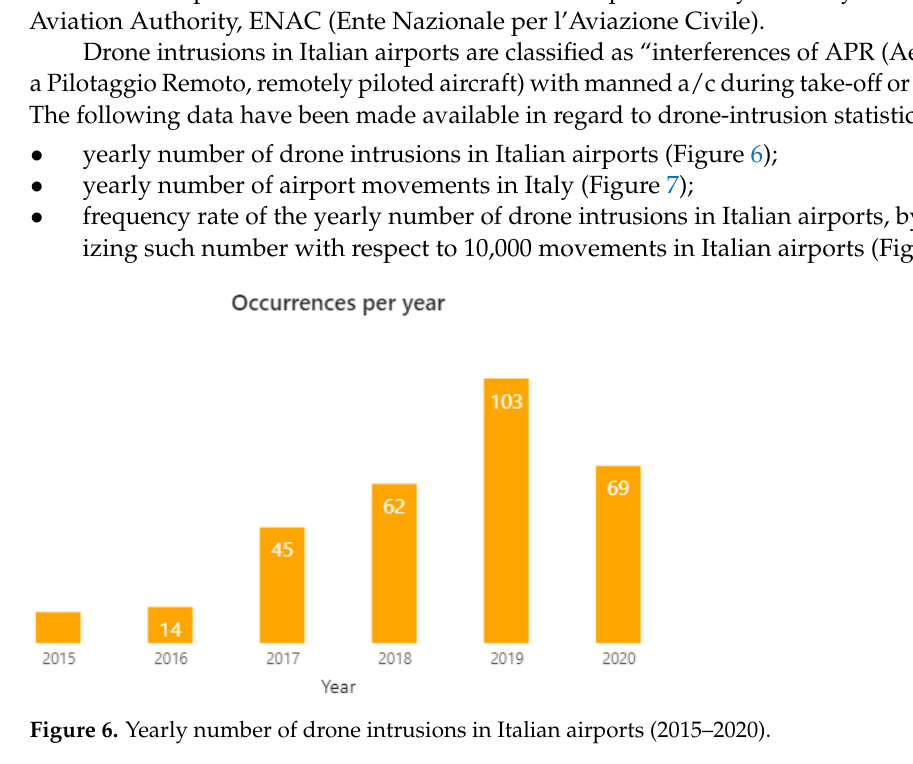
Figure 7. Yearly number of airport movements in Italy (2015–2020). Figure 8. Yearly number of drone intrusion in Italian airports per 10,000 airport movements (2015– 2020).